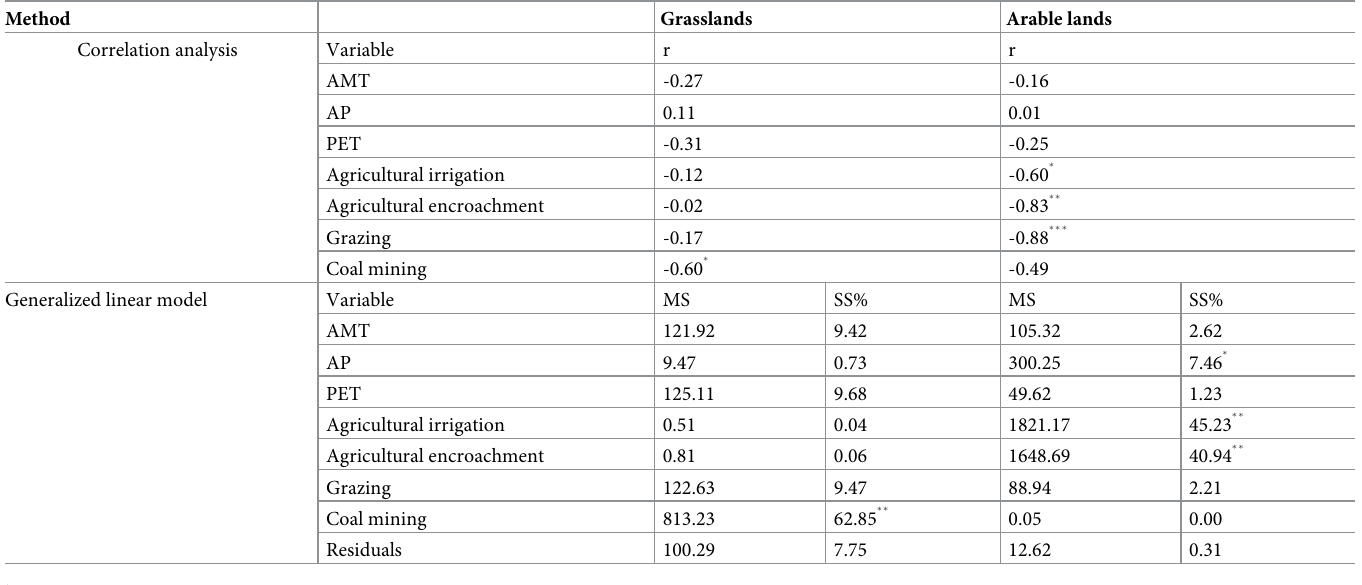
Table 4. Generalized linear model on the relationships between relative wetland areas and selected variables of grasslands and arable lands. Method